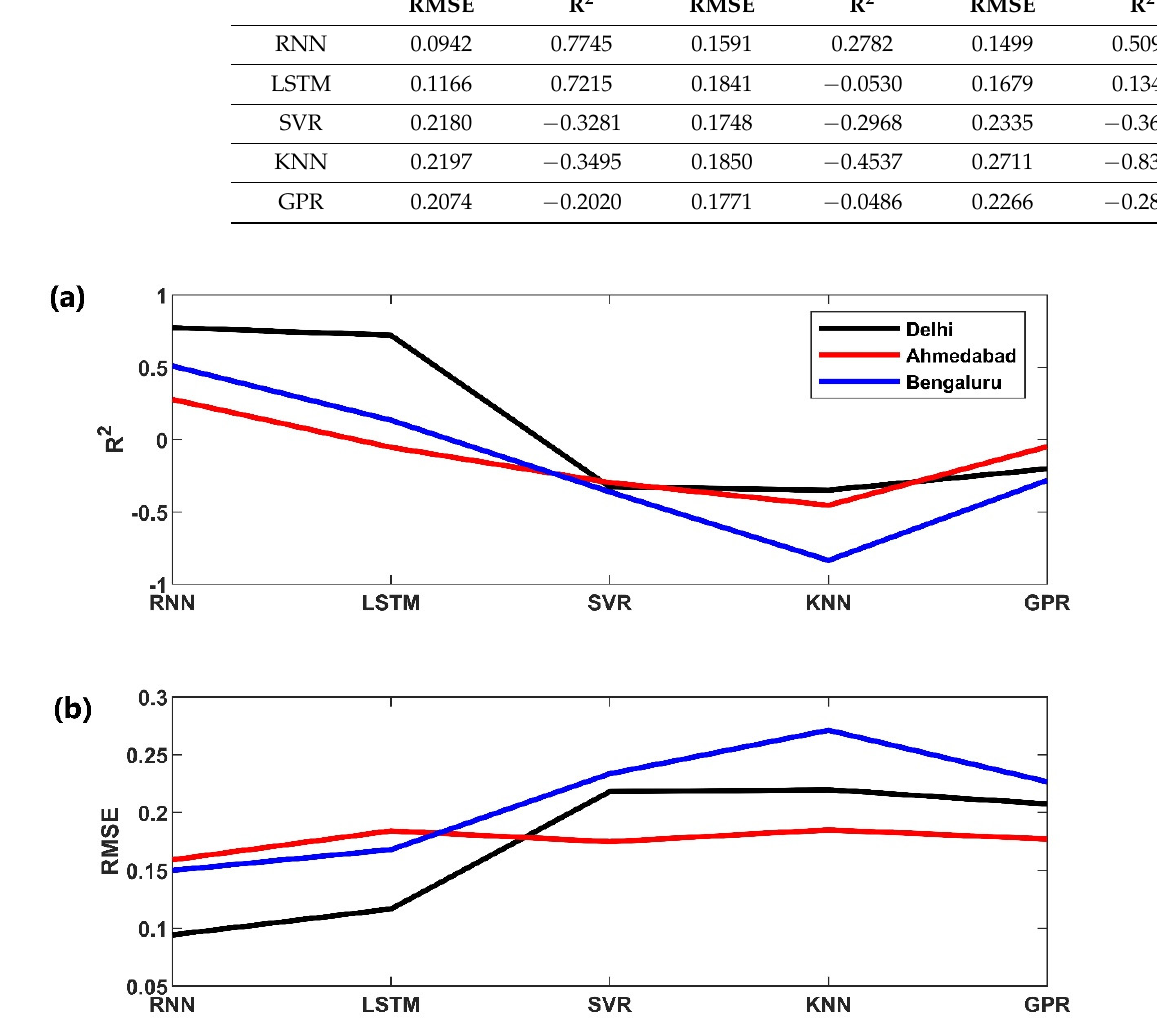
Table 3. The performance comparison of data. Delhi